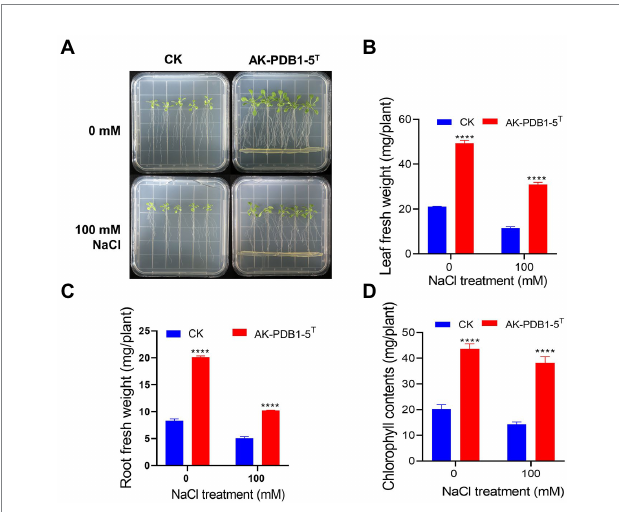
FIGURE 5 Plant growth-promoting effects of Arabidopsis seedling by strain AK- PDB1-5 T under normal and salt stress conditions. (A) Comparison of Arabidopsis seedling growth by control (no treatment, CK) and AK- PDB1-5 T co-cultivated at 22 ° C for 10 days under normal and salt stress conditions (100 mM NaCl). (B–D) Quantification of leaf fresh weight (B) , root fresh weight (C) , and chlorophyll contents (D) Error bars represent the standard error. Asterisks indicate significant differences between